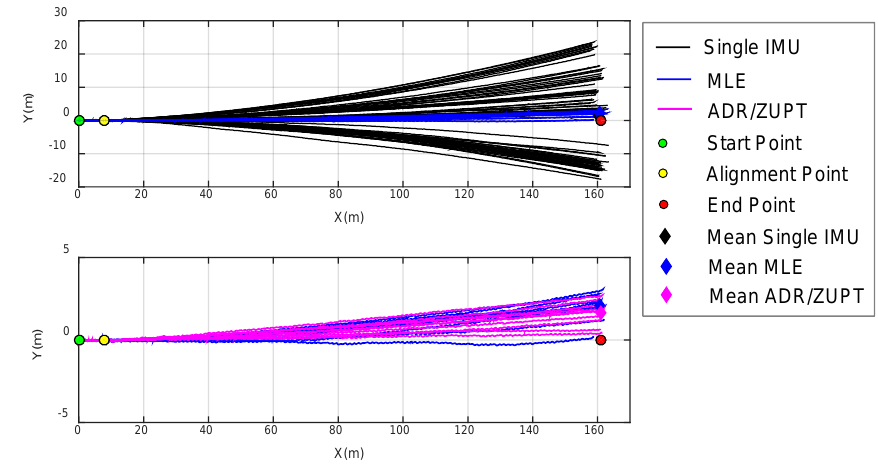
Figure 9. Estimated trajectories of different methods in 10 straight line walking experiments.